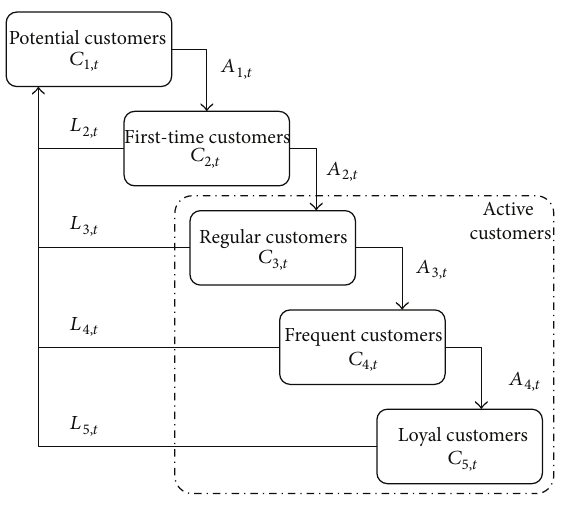
Figure 6: The relationship between different